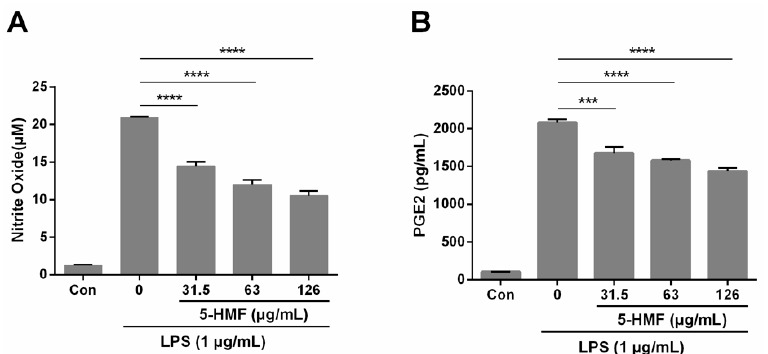
Figure 2. The suppressive effect of 5-HMF on Nitric Oxide production (NO) and prostaglandin E2 (PGE2) in RAW 264.7 cells. Cells were pretreated with various concentrations of 5-HMF for 6 h prior to the stimulation of LPS (1 μ g/mL) for 18 h. ( A ) The NO levels in the cell media were measured by Griess assays. NO production in the culture media decreased with increasing the amount of 5-HMF pretreatment. ( B ) The PGE2 levels were measured using the ELISA kit. The PGE2 levels decreased with an increase in the amount of 5-HMF pretreatment. The results are expressed as means ± SDs (n = 3). ***: P < 0.005, ****: P < 0.001, compared with the only LPS-stimulated control group.